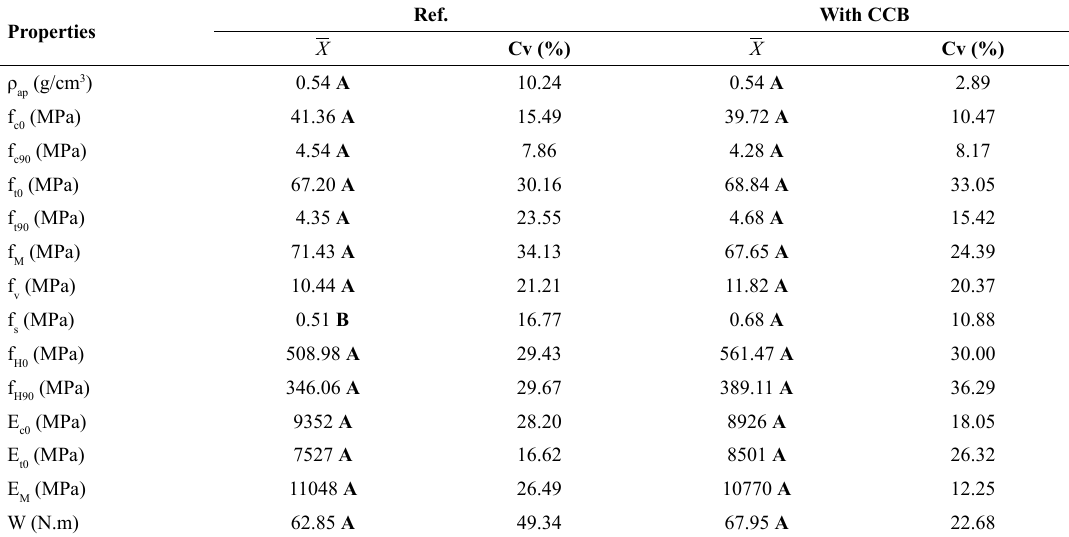
Table 4. Mean experimental values, coefficients of variation (Cv) and Tukey test results for the properties evaluated for Cedrelinga catenaeformis (Cedroarana). Properties